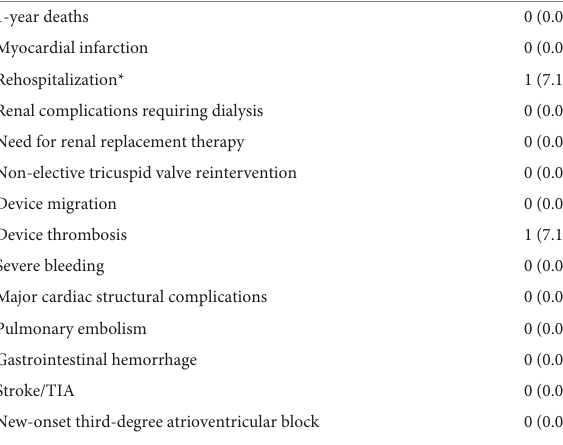
TABLE 4 Follow-up outcomes at 1 year after discharge ( N =